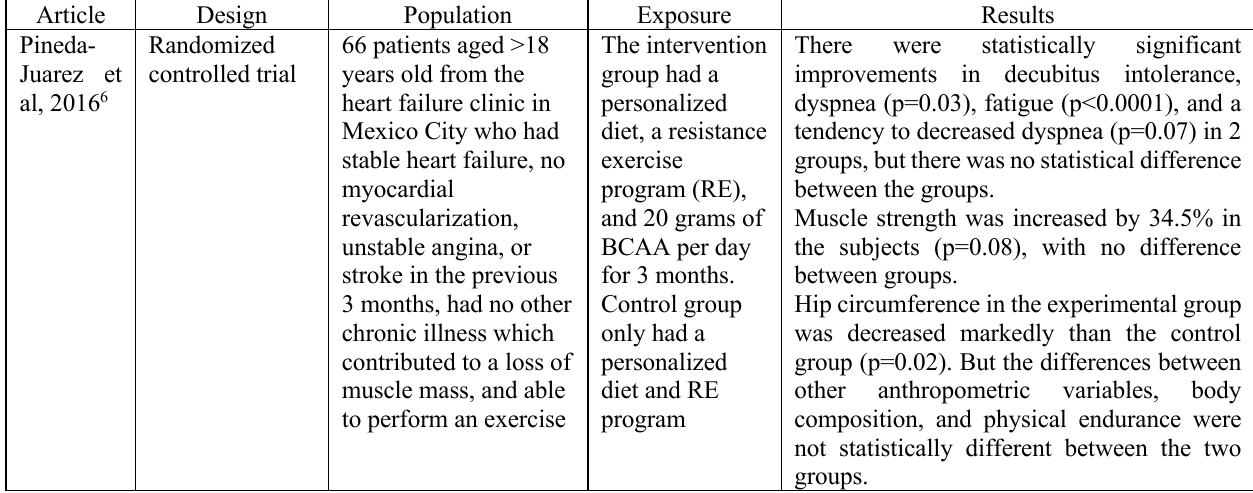
There were statistically